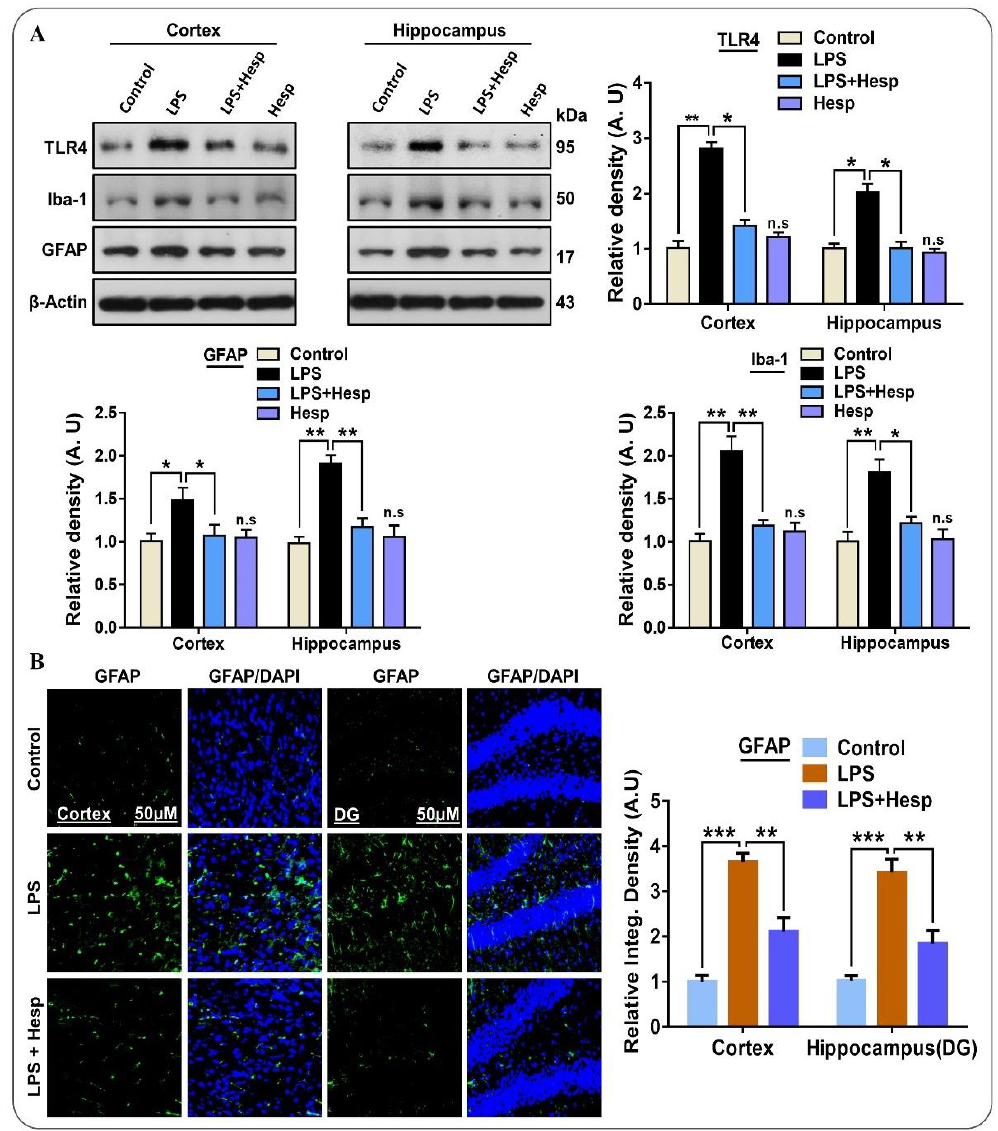
Figure 2. Hesperetin ameliorates TLR4/gliosis-mediated neuroinflammation in the LPS-treated mouse brain: ( A ) Western blot analysis showing the expression of TLR4, GFAP, and Iba-1 in the experimental mice (cortex and hippocampus regions); ( B ) confocal photomicrographs showing the immunoreactivity of GFAP in the cortex and DG region of hippocampus in different experimental mice groups. The data are presented as the mean ± SEM of 7–10 mice per group and are representative of three independent experiments, * p ≤ 0.05, ** p ≤ 0.01, *** p ≤ 0.001.